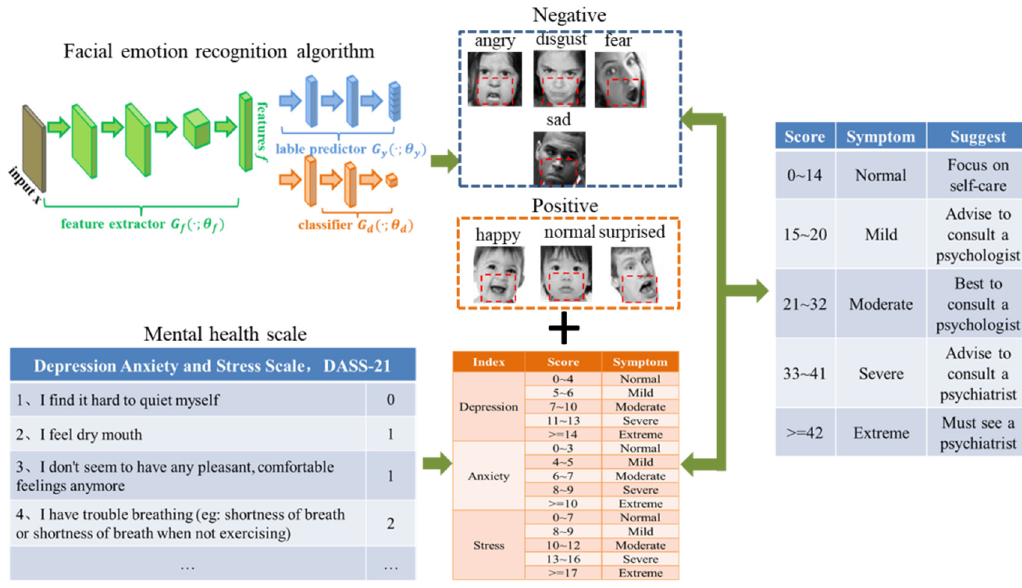
Figure 1. Full text framework. Table 2. Score grading and recommendations for comprehensive facial emotion recognition .